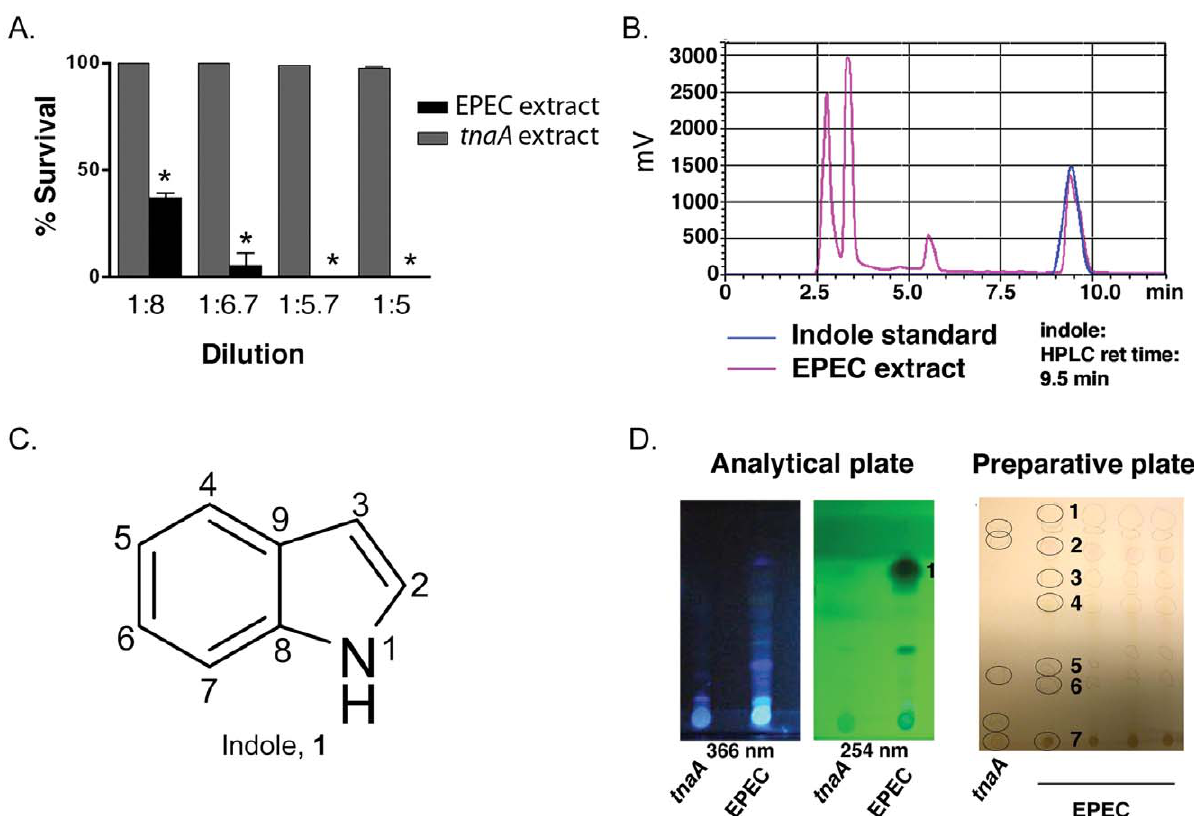
Figure 1. Identification of extract components that kill C.elegans . ( a ) Effect on C. elegans survival of dilutions of extracts derived from agar plates on which EPEC or EPEC D tnaA were grown. Extracts comprise only secreted bacterial factors because bacteria were grown on 0.2 m m nitrocellulose filters and then discarded prior to extraction of small molecules from the agar. EPEC, but not EPEC D tnaA, extracts kill C. elegans . Mean + / 2 SEM are shown; * corresponds to p , 0.001 with respect to control at each dilution. ( b ) HPLC profile of EPEC extracts or a synthetic indole standard. Note that the extract peak on the right overlaps with one seen with synthetic indole. The second peak from the left corresponds to tryptophan, and the third to ICA (see Fig. S3a). ( c ) Structure of indole. ( d ) Images of analytical and preparative TLC plates used for separation of EPEC and EPEC D tnaA extracts. The preparative plate was imaged under visible light, and numbers and circles indicate spots, evident under UV illumination, onto which agar filled cylinders were placed and to which C. elegans were added. Only spot # 1 killed C. elegans